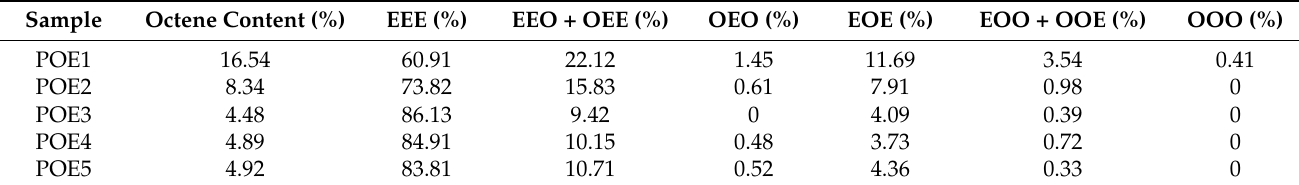
Table 2. Triad sequence length distribution of POEs by 13 C-NMR